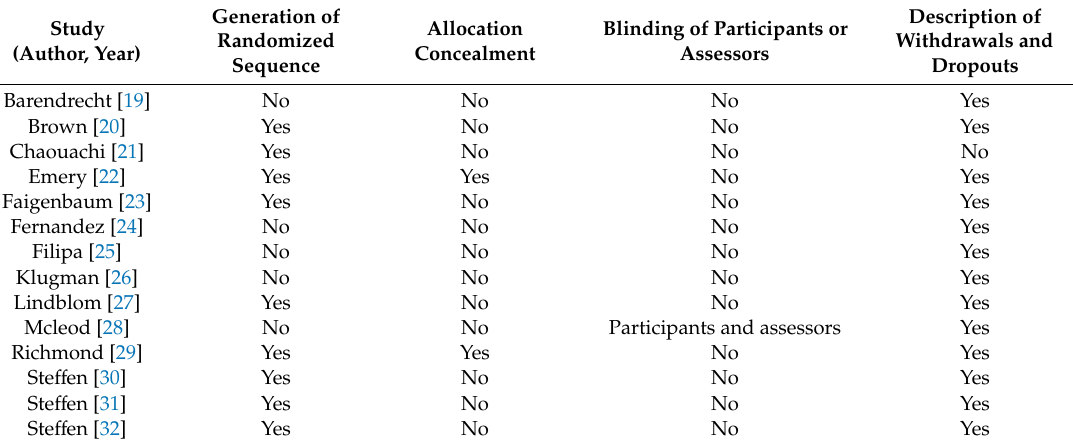
Table 1. Quality assessment of